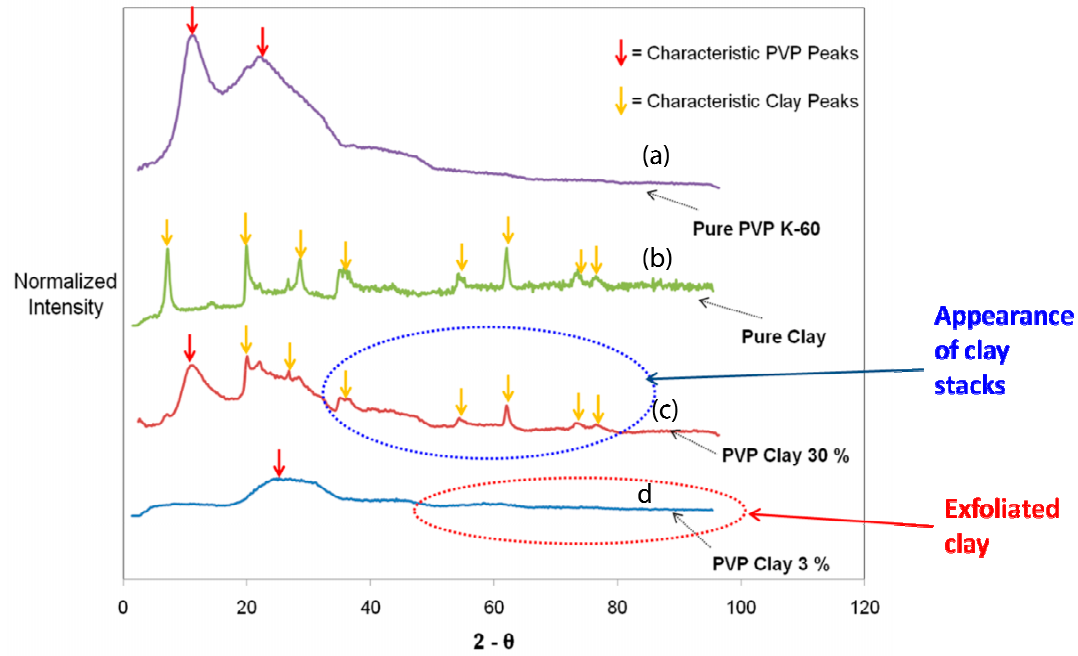
Figure 5. XRD Figure 5. XRD spectra.